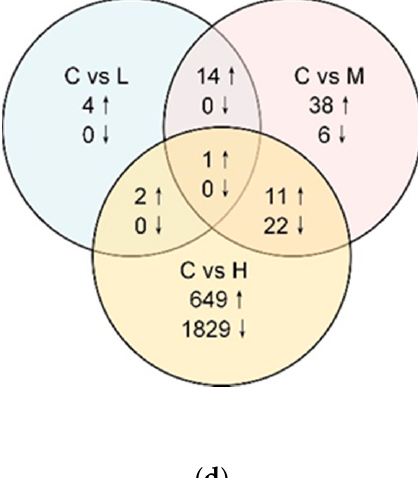
Figure 2. Transcriptomic analysis of LIN dosing groups in alga R. subcapitata on day 7. ( a ) Correlation test of DEGs in each group. ( b ) PCA of FPKM profiles of DEGs after adding ROX. ( c ) A heatmap of centered and scaled FPKM values of DEGs in all dosing groups of R. subcapitata . ( d ) Venn diagram of the distribution of DEGs in each group. C: control group; L: low treatment group; M: medium treatment group; H: high treatment group.